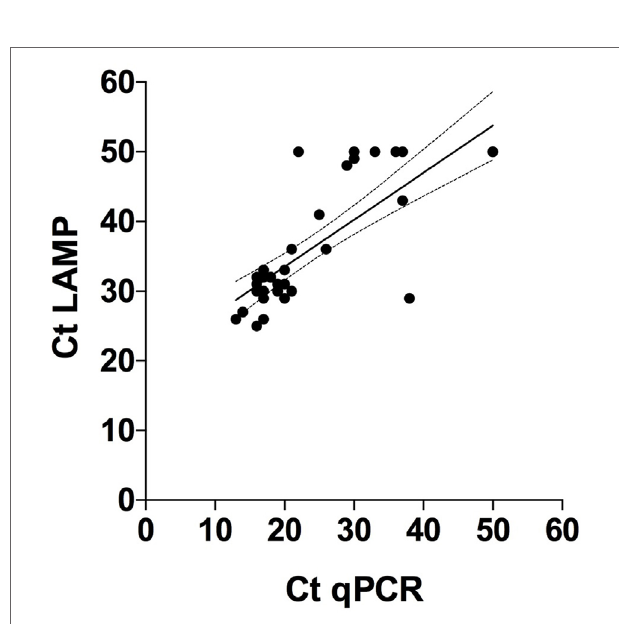
FigUre 4 | Correlation between cycle threshold (Ct) values obtained with quantitative polymerase chain reaction (qPCR) and loop-mediated isothermal amplification (LAMP) on DNA extractions from 38 individual sheep feces samples tested with these diagnostic methods. Tests that gave no results were arbitrarily set to 50. Spearman rank = 0.7 ( p < 0.0001), 95% confidence interval = 0.6 and 0.9 for qPCR and LAMP,